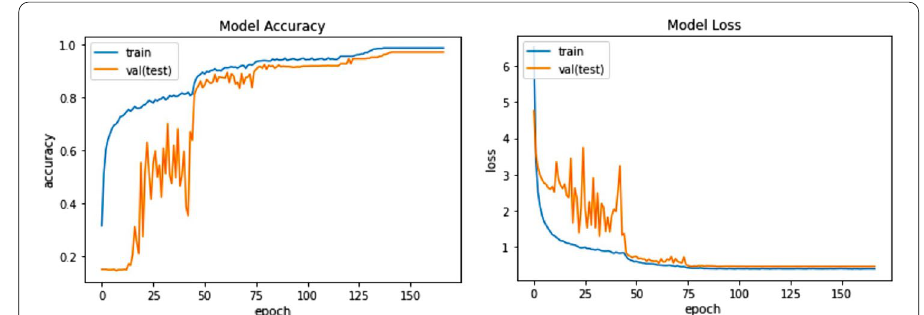
Fig. 8 Training and testing accuracy and loss of ARCH-1 with IMED